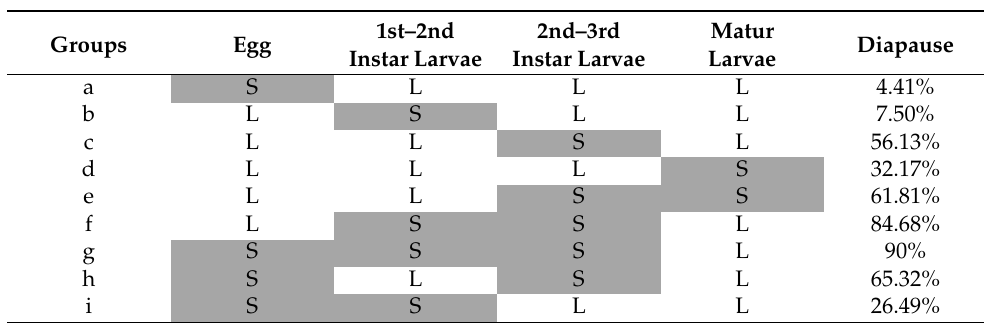
Table 1. Incidence of diapause of mature larvae after culturing Anastatus japonicus individuals under diapause-preventing condition (L: 24 ◦ C, 16L:8D) and transferring them to diapause-inducing condition (S: 17 ◦ C, 6L:18D) at different